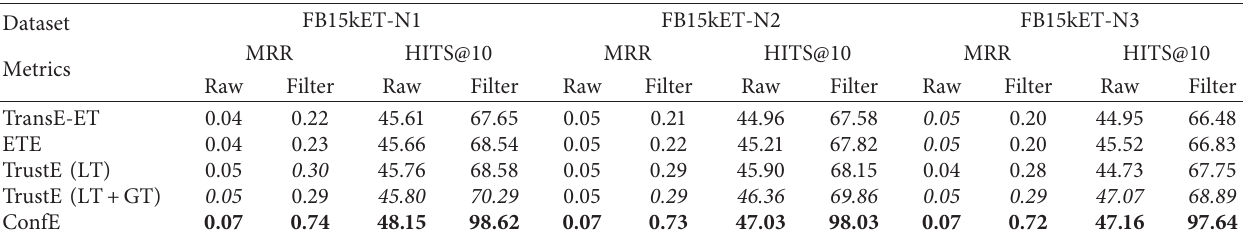
Figure 3: Entity type noise detection results. Evaluation on (a) YAGO43kET-N1, (b) YAGO43kET-N2, and (c) YAGO43kET-N3. Table 3: Entity type prediction results. Evaluation of different models on FB15kET-N1, FB15kET-N2, and